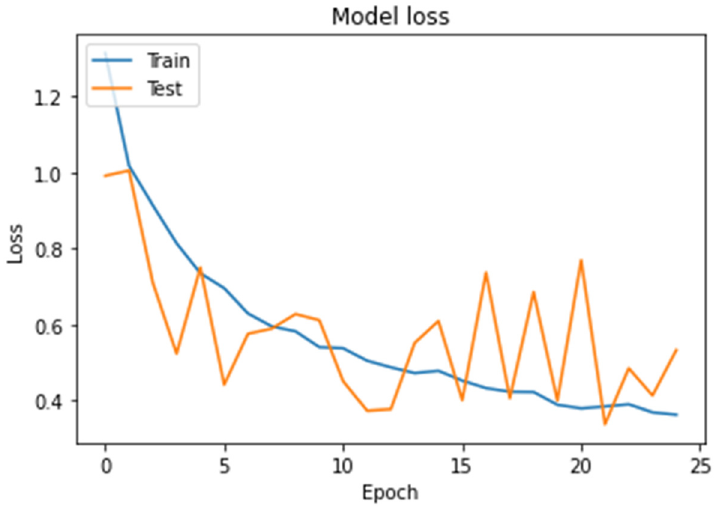
Figure 8. Plot of training and testing loss with respect to each epoch. Figure 8 . Plot of training and testing loss with respect to each epoch. Figure 8 . Plot of training and testing loss with respect to each epoch.